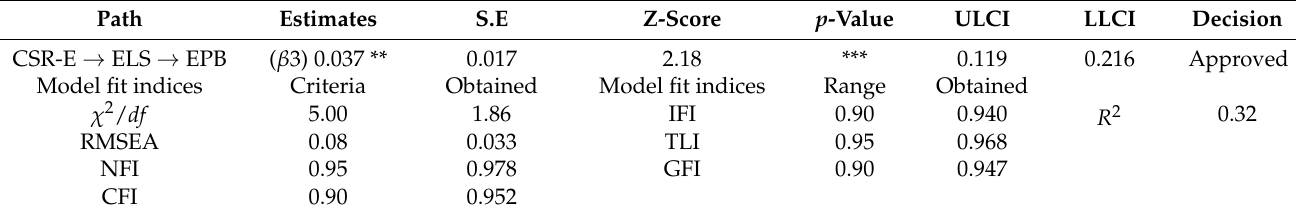
Table 5. Mediation and moderation results for Hypotheses (H3) and